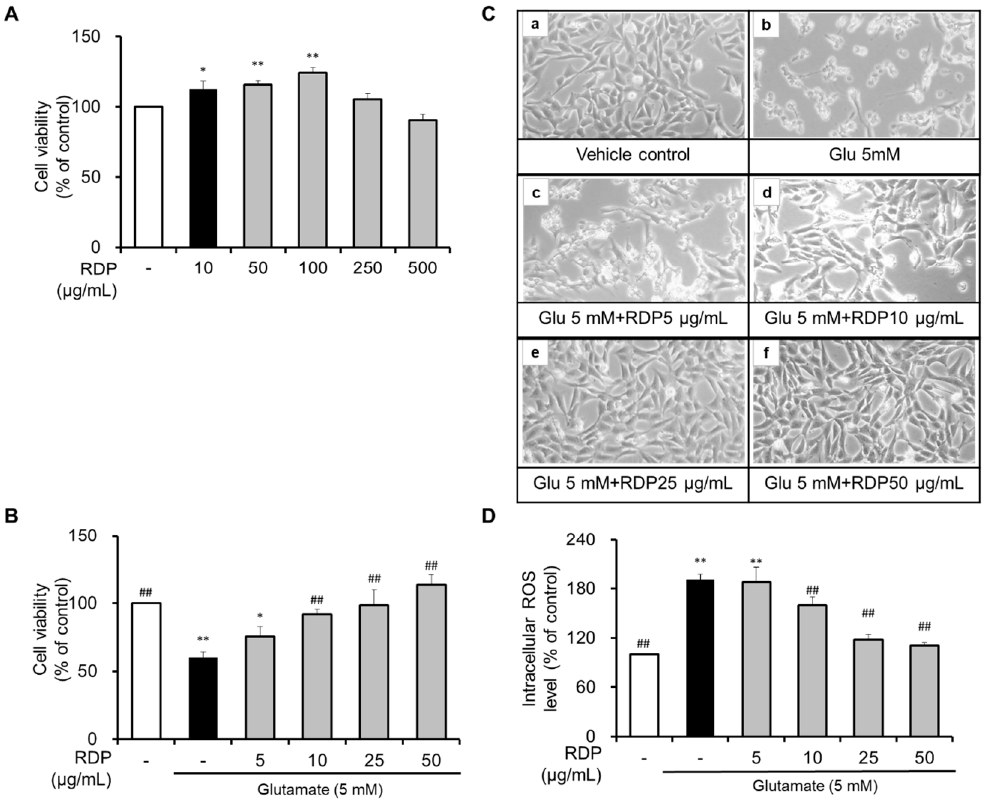
Figure 3. Neuroprotective effect of ethyl acetate extract of Ribes diacanthum Pall (RDP) on glutamate-induced cytotoxicity in HT-22 cells. ( A) and ( B) Cell viability, ( C ) morphology change in ( a ) vehicle control and cells treated with ( b ) glutamate 5 mM; ( c ) glutamate 5 mM + RDP 5 µ g / mL; ( d ) glutamate 5 mM + RDP 10 µ g / mL; ( e ) glutamate 5 mM + RDP 25 µ g / mL, and ( f ) glutamate 5 mM + RDP 50 µ g / mL. ( D ) Intracellular ROS levels. HT-22 cells were seeded at 3 × 10 3 cell / well for 24 h. Then, the cells were treated with glutamate in the presence or absence of varying concentrations (0–50 µ g / mL) of RDP for 12 h. Cell viability was measured using the EZ-Cytox Cell Viability Assay Kit. All data are presented as the mean ± S.E.M. The results were calculated as a percentage of the values obtained for control cells. * p < 0.05, and ** p < 0.01 versus vehicle control; ## p < 0.01 versus glutamate-treated group–indicates absence.